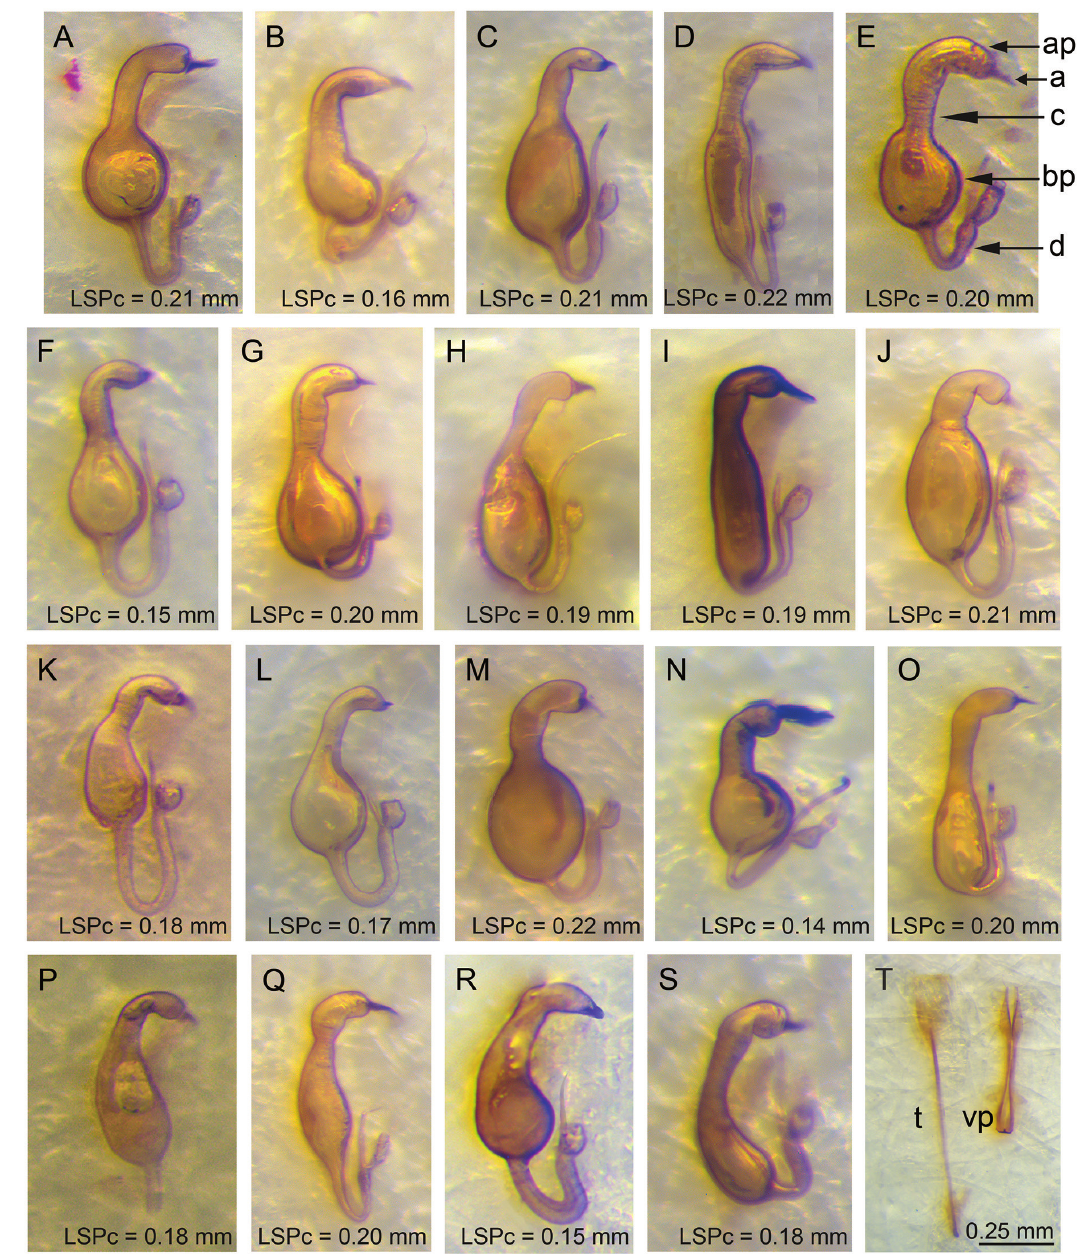
Fig. 11. Female genitalia. A – S . Spermatheca. A . Arsipoda agalma Samuelson, 1973, N of Pic Vincent.